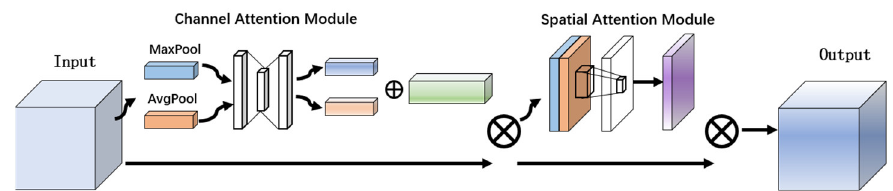
Figure 3. CBAM attention module.